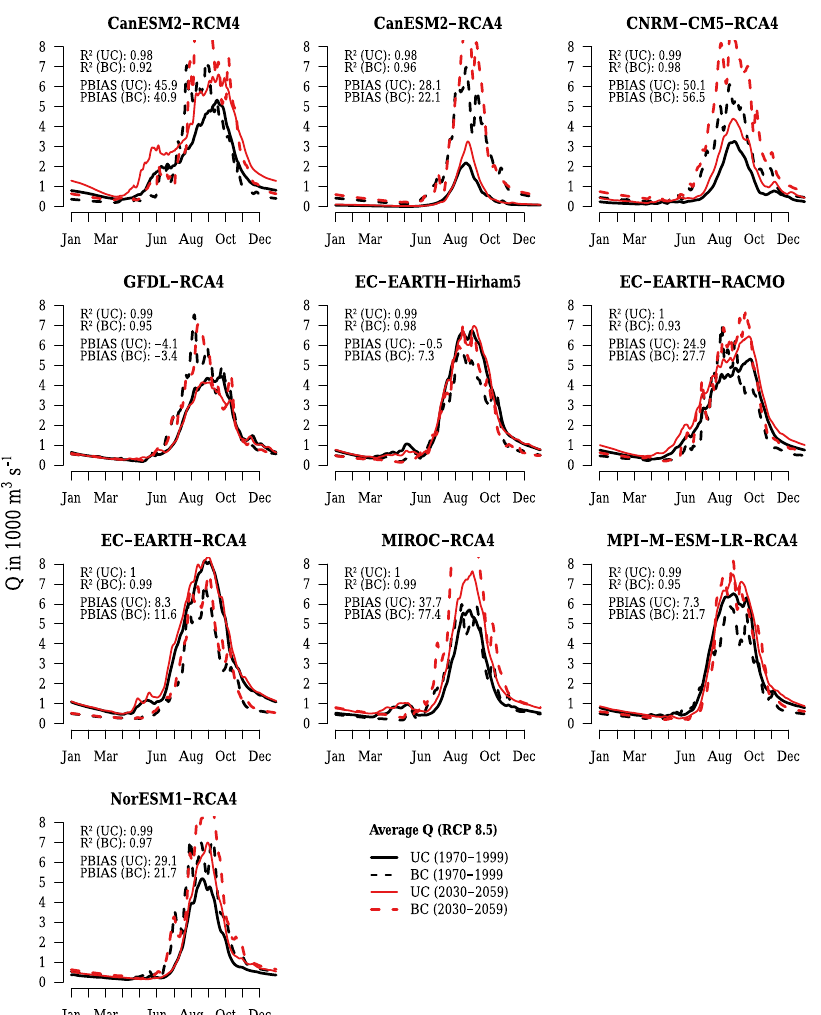
Figure 11. Changes of average daily discharges at gauge El Diem based on uncorrected (UC) and bias-corrected (BC) regional climate model (RCM) input in the period (2030–2059) under RCP8.5 relative to the models’ reference period (1970–1999). R 2 and PBIAS values are computed to show the differences between the projection period and the reference